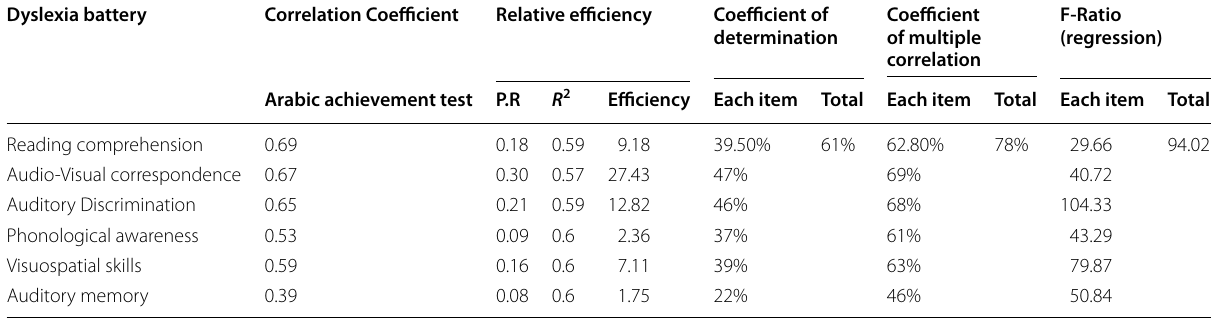
Number of Cases (373); PROB > (0.001)